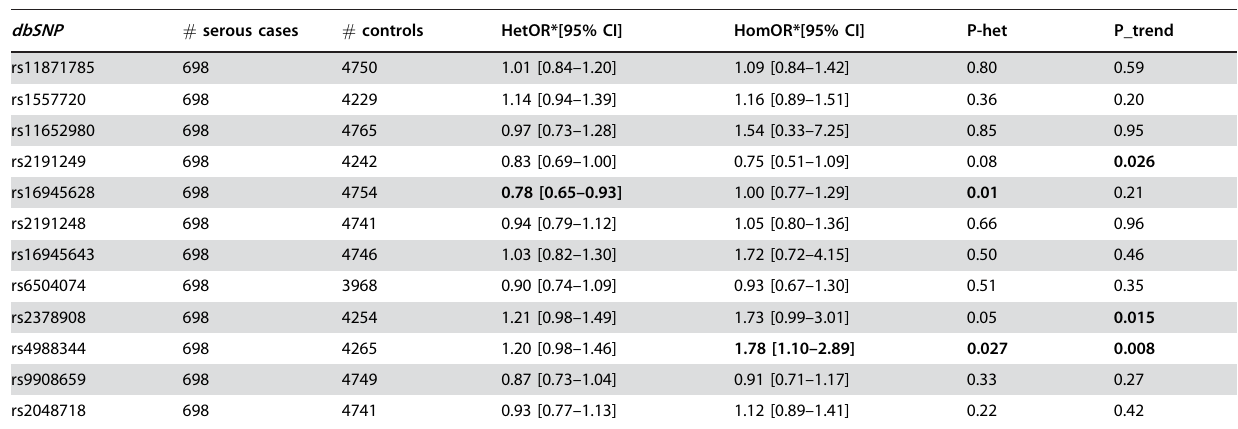
Table 2. Serous type ovarian cancer genotype specific risks for each tSNP .. ... .... ... ... .... ... ... .... ... ... .... ... ... .... ... ... .... ... ... .... ... ... .... ... ... .... ... ... .... ... ... .... ... ... .... ... ... .... ... ... .... ... ... .